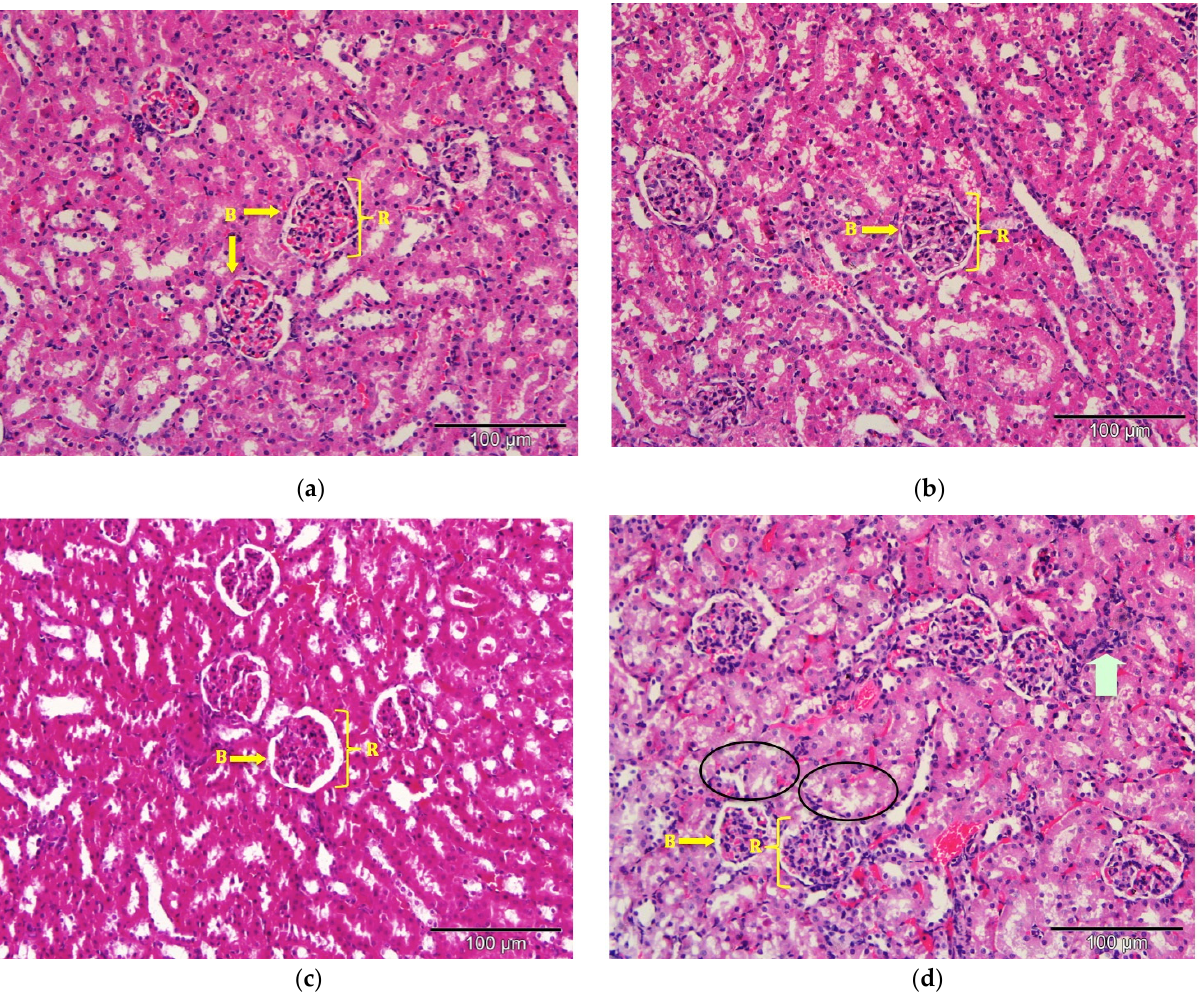
Figure 7. Photomicrograph of kidney tissues from ( a ) control; ( b ) commercial acyclovir suspension; ( c ) drug-free SLN and ( d ) acyclovir-loaded SLN treated groups (H&E stain, 200×). Interstitial infiltration of inflammatory cells (arrowed) and acute necrosis of renal tubules (circle). B: Bowman’s capsule, R: renal corpuscles.